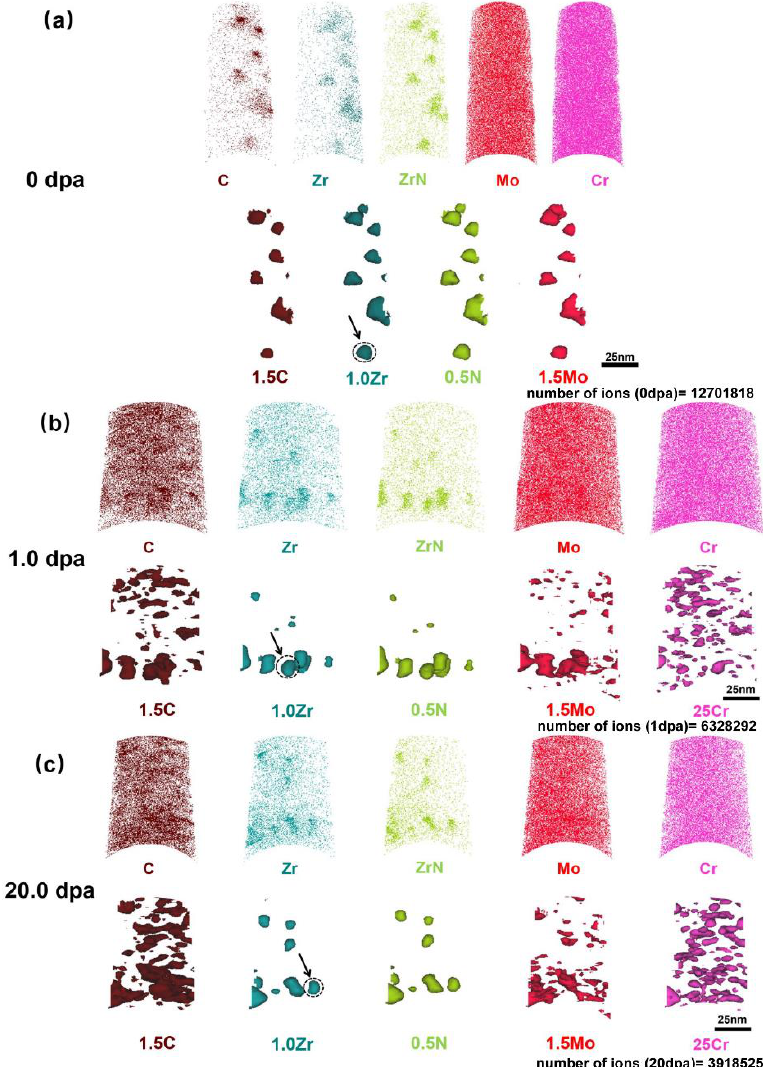
Figure 7. 3D distribution maps of C, Zr, ZrN + , Mo, and Cr, as well as the iso-concentration surfaces of 1.5 at % C, 1.0 at % Zr, 0.5 at % N, 1.5 at % Mo, and 25 at % Cr, at different irradiation doses measured by APT: ( a ) 0 dpa, ( b ) 1.0 dpa, and ( c ) 20.0 dpa. Since the Cr is distributed homogeneously in the unirradiated specimen, it is not necessary to make iso-concentration surfaces of Cr. The three Zr-enriched domains in the dotted circle, indicated by the black arrow, will be separately selected for analysis later.